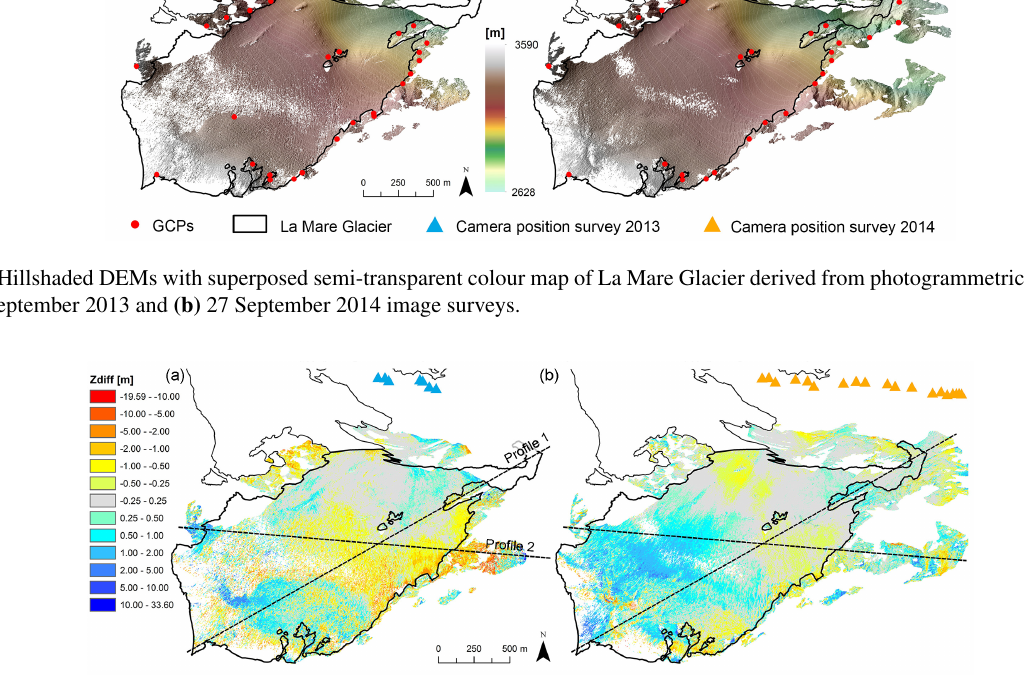
Figure 6. Spatial distribution of elevation differences between photogrammetric and ALS-based DEMs for (a) 2013 and (b) 2014. Black lines are the location of profiles in Fig.